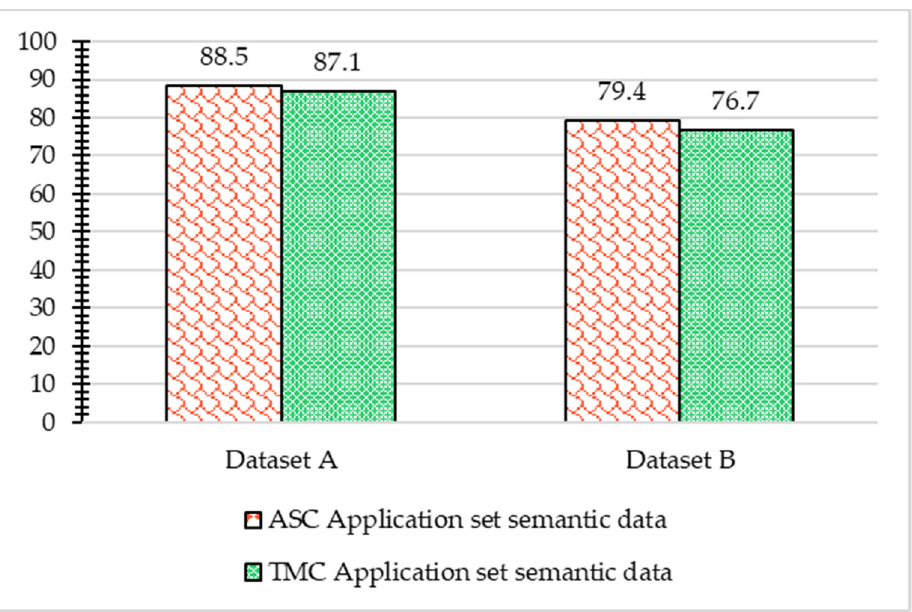
Figure 30. Overall data quality assessment for the ASC and TMC application.